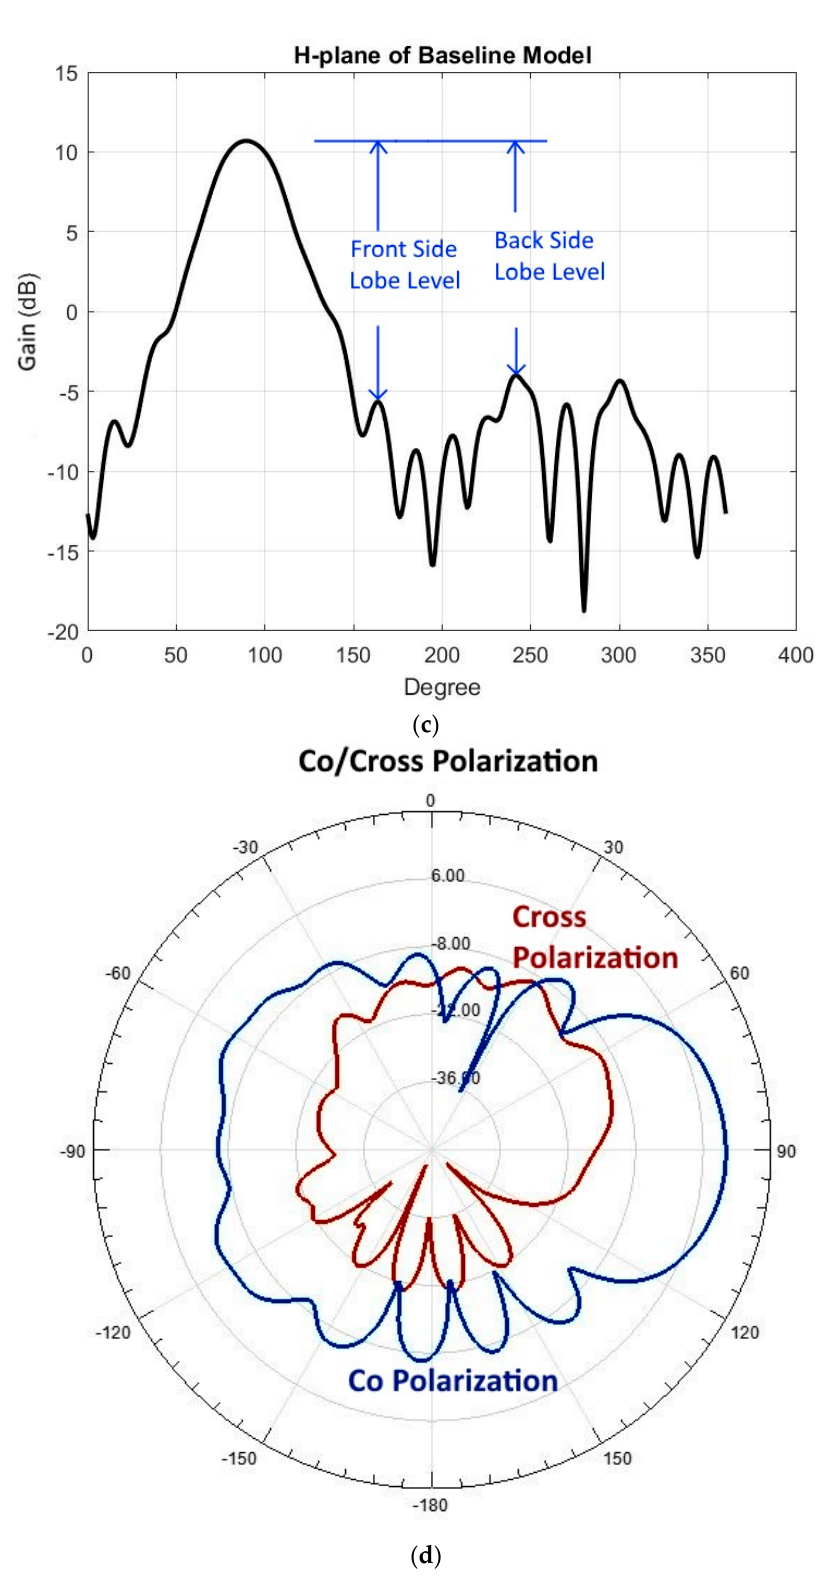
Figure 2. Baseline model characteristics: ( a ) S11, ( b ) E-plane, ( c ) H-plane, and ( d ) co/cross polarization (Blue: copolarization, Red: cross polarization).